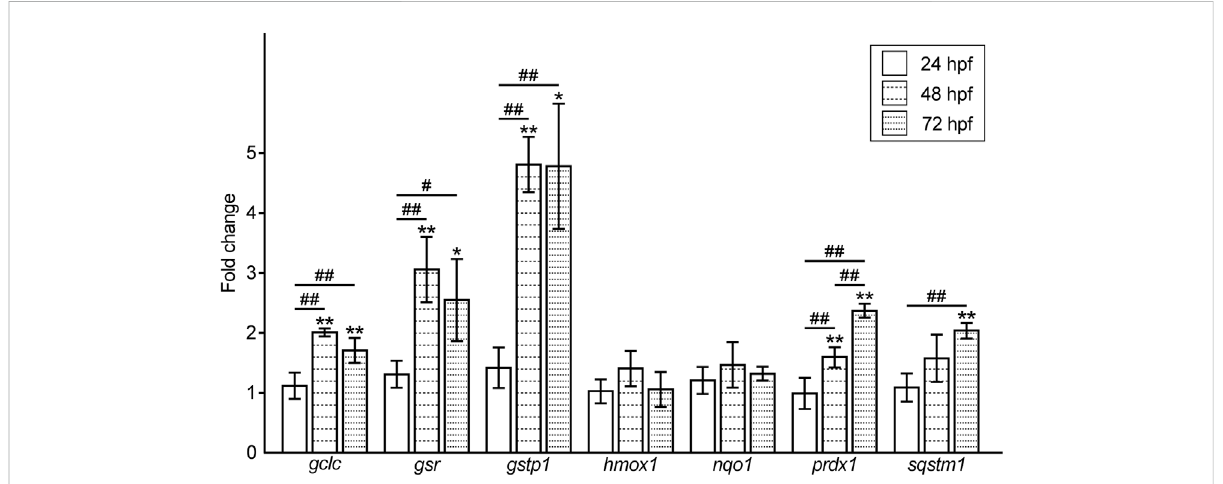
Fold changes in the expression level of oxidative stress response-related genes in the Pb-exposed (100 ppb Pb) zebra fi sh embryos/larvae compared to the control (0 ppb Pb). The values of the fold changes at 24, 48, and 72 hpf are shown in the bar graph representing the mean ± SD. Statistical signi fi cance between control and Pb-exposed groups at each time point was calculated by the Student ’ s t-test. * p < 0.05, ** p < 0.01. Statisticalsigni fi canceamongtimepointwascalculatedbyone-wayanalysisofvariance(ANOVA)followedbyTukey-Kramer honestsigni fi cant